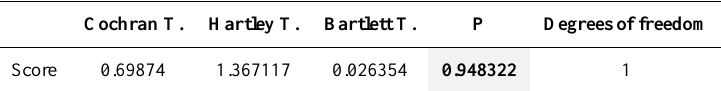
Table 4. Test of variance homogeneity